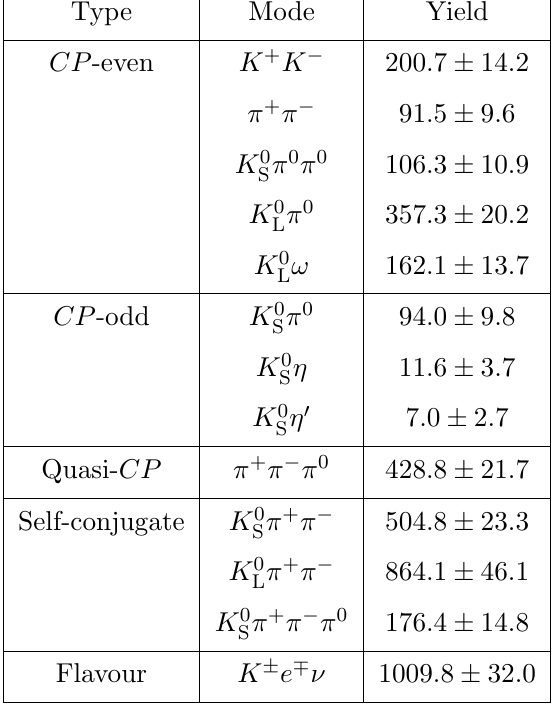
Figure 6 . Dalitz plot distributions for the tags (a) K 0 K 0 (cid:25) + (cid:25) (cid:0) (cid:25) 0 decays. The axis labels m 2 S